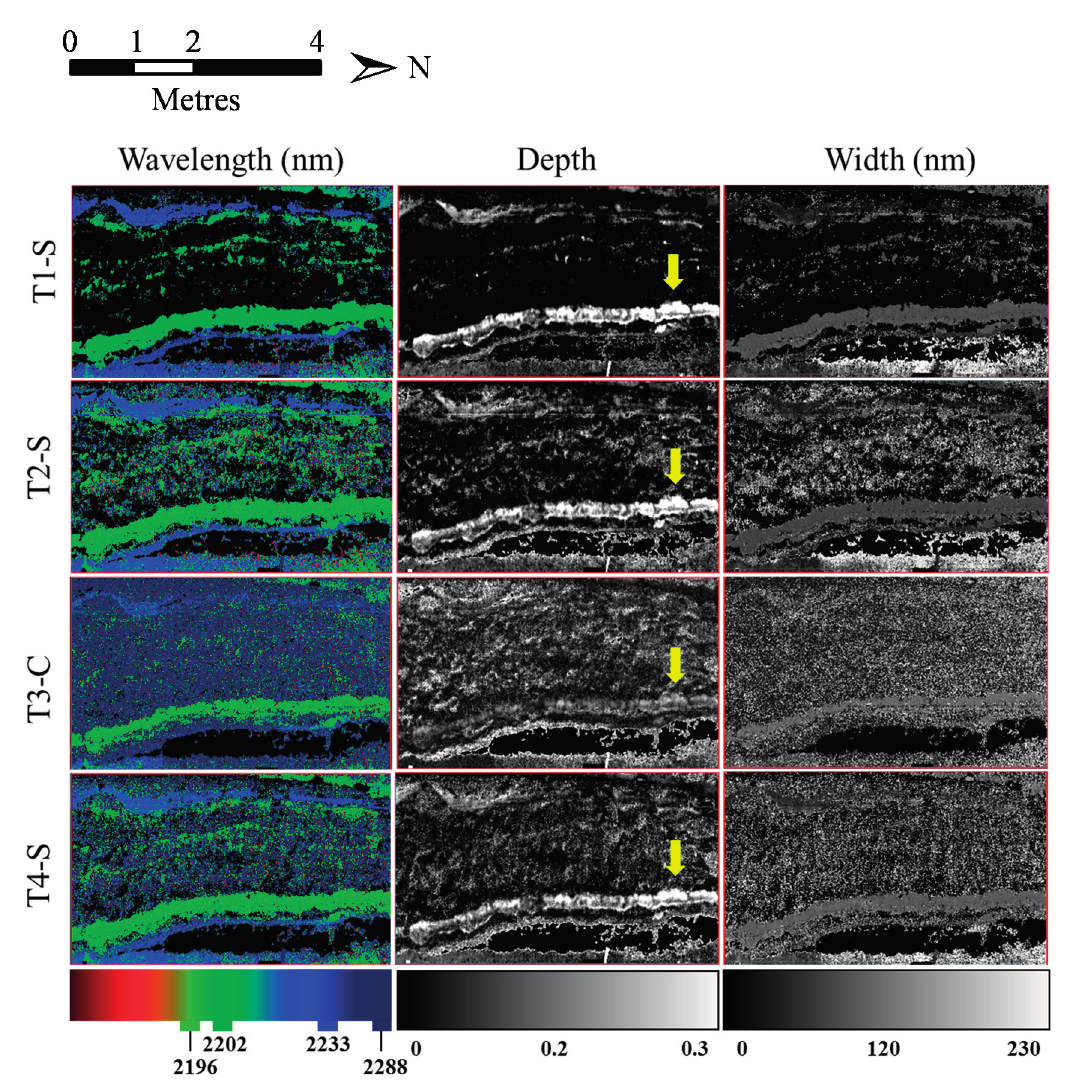
Figure 7. Images of absorption feature parameters, wavelength position, depth and width for Subset 1 (see Figure 1 for context) of images acquired under different conditions of illumination. Pixel spectra which had a minimal hull-quotients reflectance value of 0.95 or less were considered to have a coherent absorption feature. The feature parameters of these pixels were then calculated by the AFE algorithm; all other pixels were set to zero (black pixels in the images). Color/grey-scale ramps are shown at the bottom. The arrow in the images representing depth indicates an area of intense absorption by clay minerals (see text for